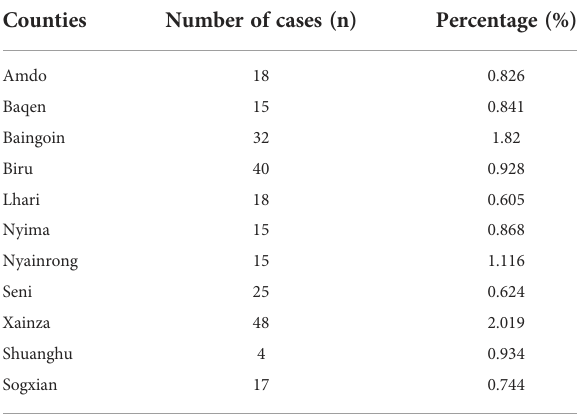
TABLE 6 Incidence of HSIL or severe lesion among Tibetan women in different areas.